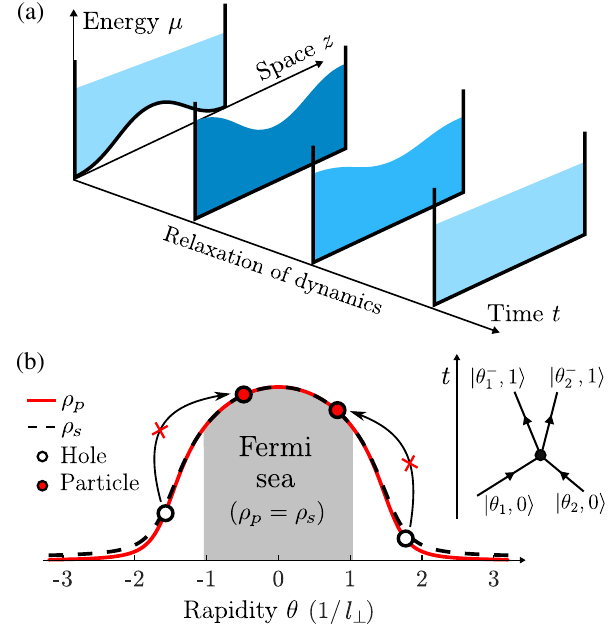
FIG. 1. (a) Illustration of the geometric quench setup. The gas is initialized in a 1D box trap whose bottom is sinusoidal. At time t ¼ 0 , the potential is quenched to a flat box, initiating the dynamics. (b) Schematic of emergent Pauli blocking. Excitations in the transverse confining potential can occur following colli- sions between quasiparticles with large, opposite rapidities ffiffiffi p 8 =l ⊥ . Here an excitation from the ground state j 0 i to the first excited state j 1 i is depicted. The process corresponds to creating two particle-hole pairs with rapidities θ − θ 1 ; 2 . If the rapidities of the outgoing particles are already 1 ; 2 and occupied, the transverse excitation cannot occur by virtue of the fermionic quasiparticle